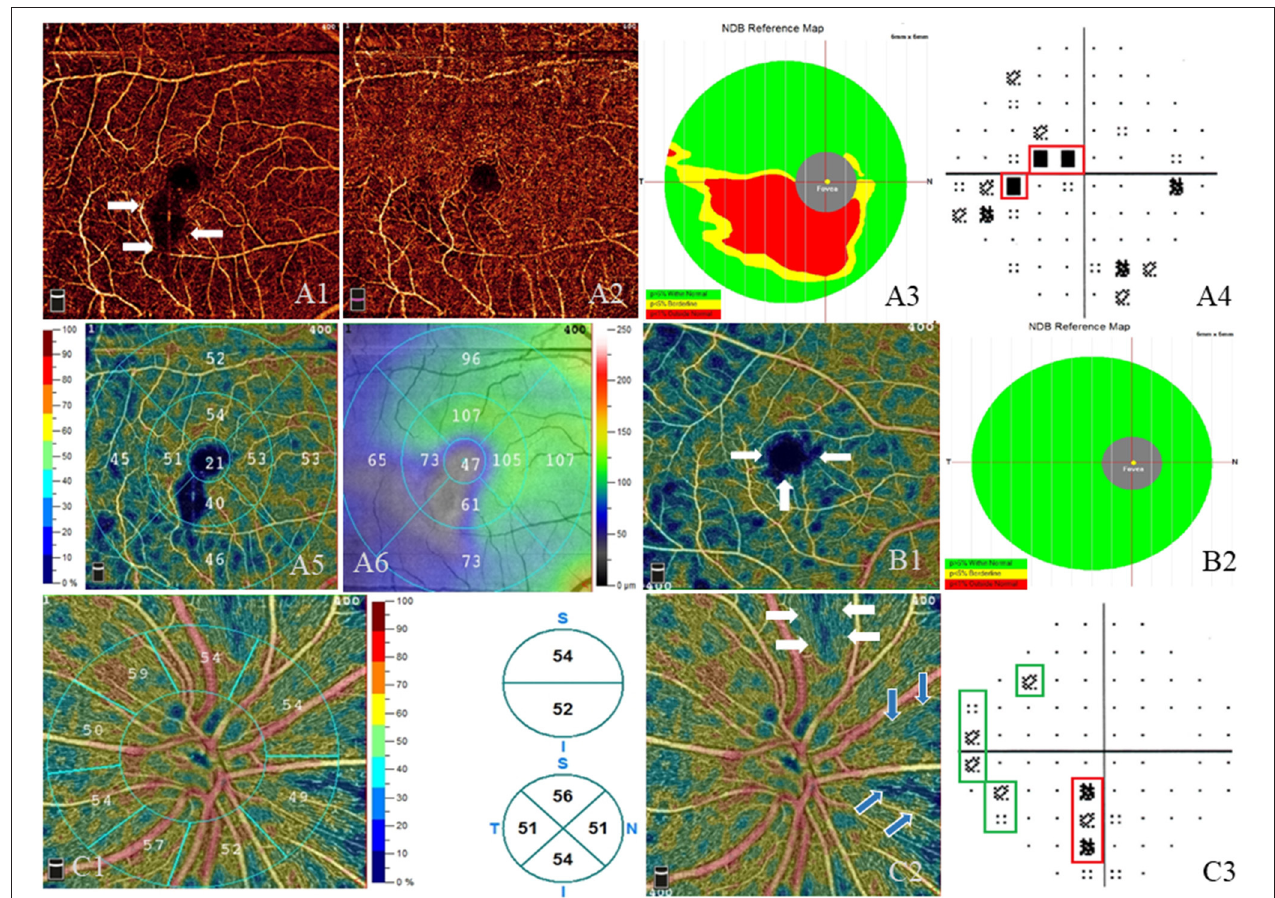
FIGURE 3 | Visual field defects and impairment in the macular and optic nerve head (ONH) areas. (A–C) Three different radiation encephalopathy patients. (A) The right eye of a radiation encephalopathy patient (RE-1). (A1) Lower vessel density (white arrows) adjacent to the macula in the superficial vascular plexus (SVP, from internal limiting membrane to inner plexiform layer). (A2) Less obvious lower vessel density in the corresponding location in the deep vascular plexus (from inner plexiform layer to outer plexiform layer). (A3) Significantly reduced ganglion cell complex thickness (red area) in the corresponding location. (A4) The corresponding central scotoma (red line) in the pattern standard deviation (PSD) map. (A5) The vessel density of different sectors in the SVP layer and corresponding lower vessel density in the inferior. (A6) Retinal thickness of different sectors in the SVP layer and corresponding thinner thickness in the inferior and the temporal. (B) The right eye of RE-2. (B1) Enlarged foveal avascular zone (white arrows) and diffused vessel density reduction (dark blue area) in the SVP layer. (B2) Normal ganglion cell complex thickness in the corresponding location. (C) The right eye of RE-3. (C1) Left: the vessel density of different sectors in the radial peripapillary capillary plexus (RPCP) layer, lower vessel density in the nasal inferior; right: the vessel density of hemifield (up) and of quadrant (down) in the RPCP layer. (C2) Lower RPCP (white arrows and blue arrows) near the ONH. (C3) The corresponding visual field defect (red line and green lines) in the PSD